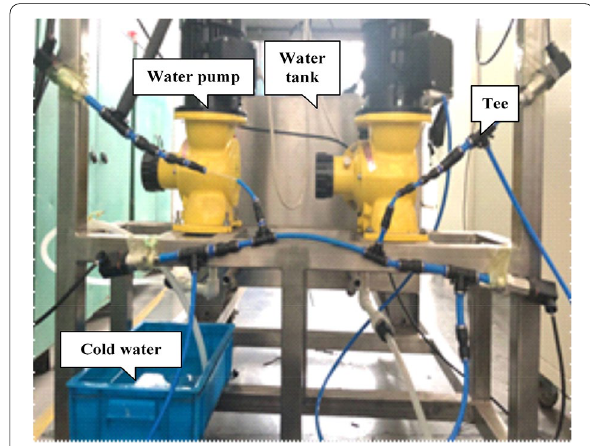
Figure 6 The experimental station of the simulated heat transfer system Table 1 Experimental parameters